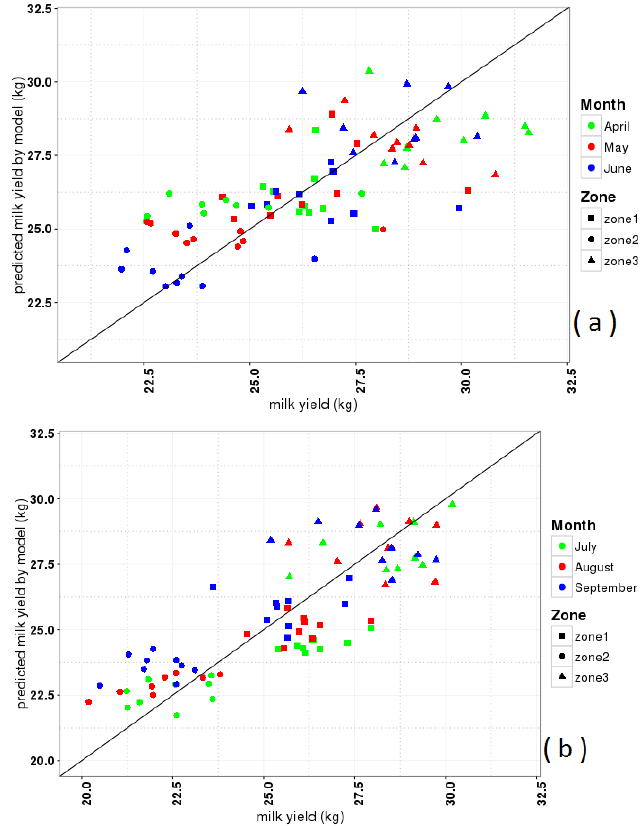
Figure 7. Layout data (observed) of milk yield vs. predicted milk yield data by models in spring ( a ) and summer ( b ). Months indicated by colors and zones (Figure 1) by different symbols.